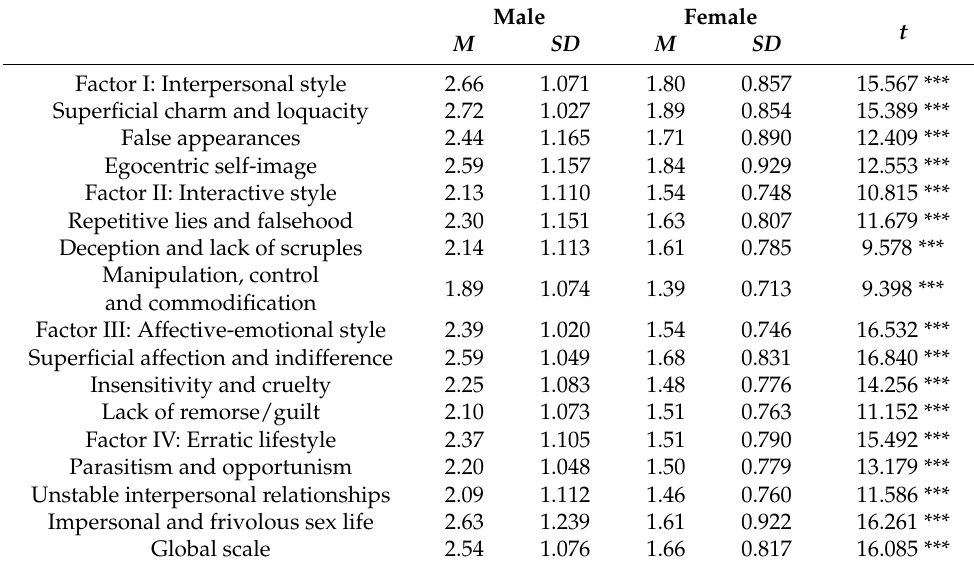
Table 1. Comparison of averages in subclinical psychopathy with respect to gender.